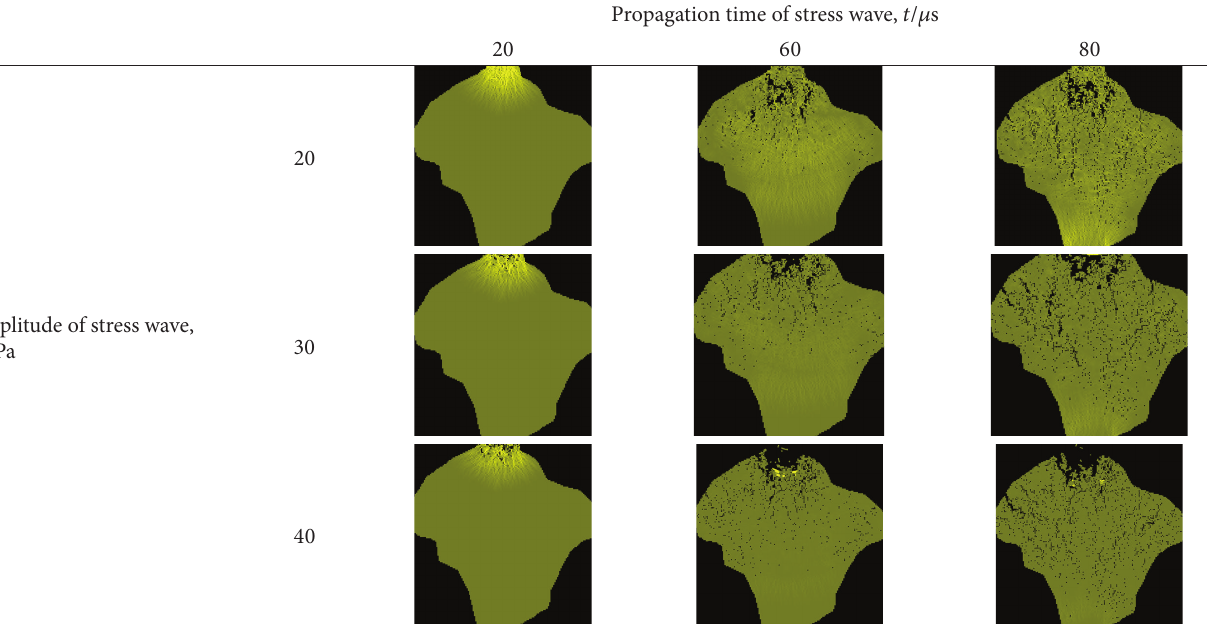
Table 2: Fracturing process of sample under stress waves with different